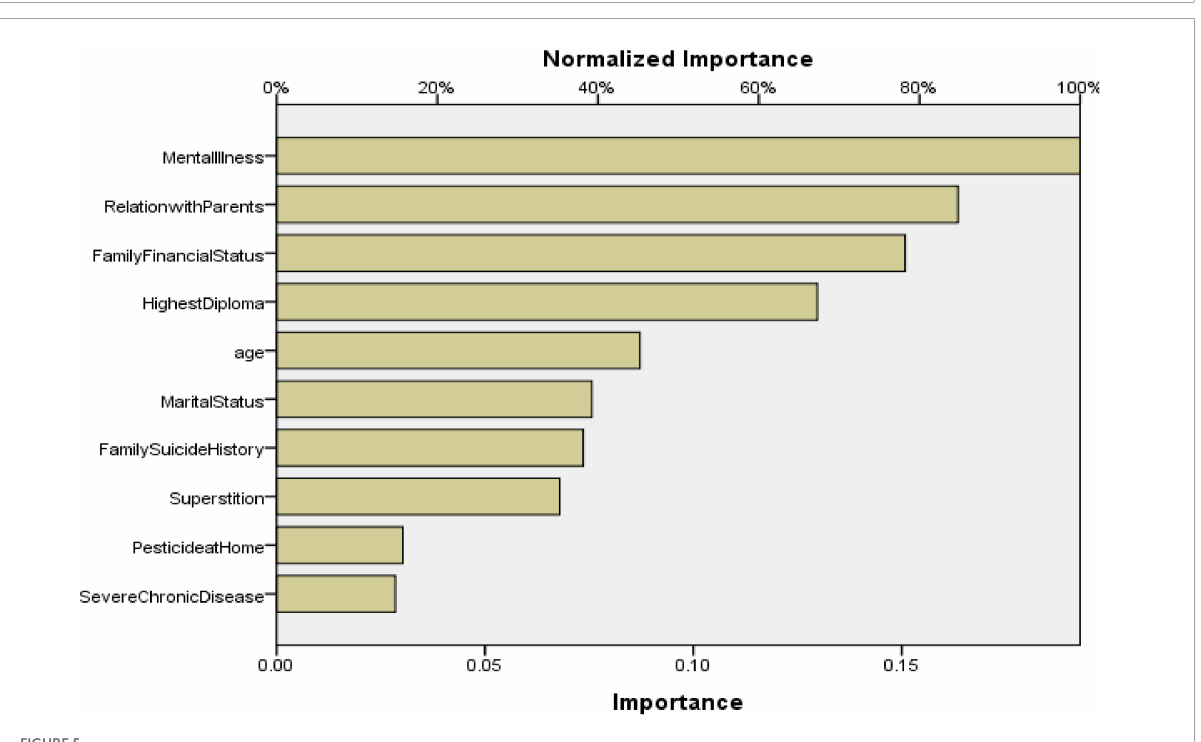
FIGURE5 Importance chart of independent variables of multilayer